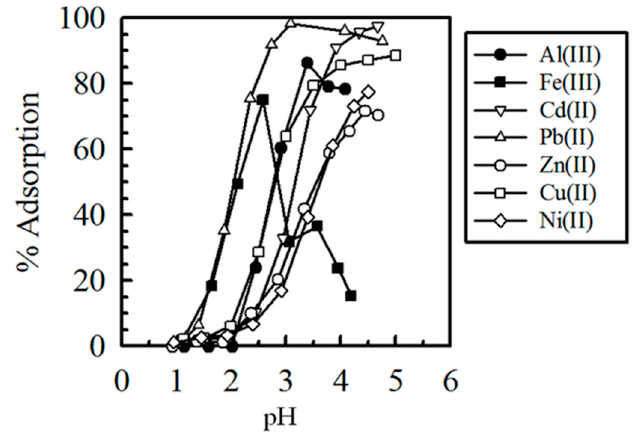
Figure 32. % adsorption of some metal ions by Laminaria japonica gel cross-linked with epichlorohydrin at different pH values.